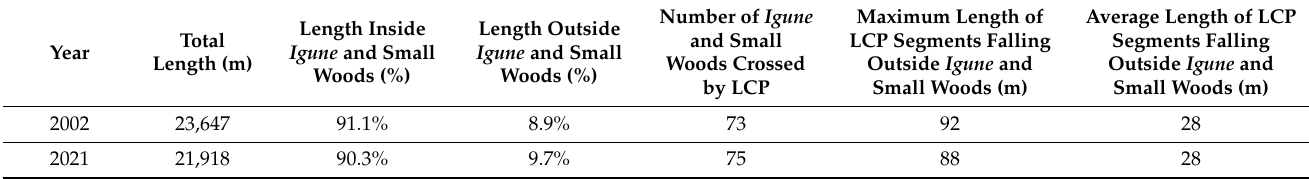
Table 3. Spatial metrics calculated for the Least-Cost Path analysis for 2002 and 2021.